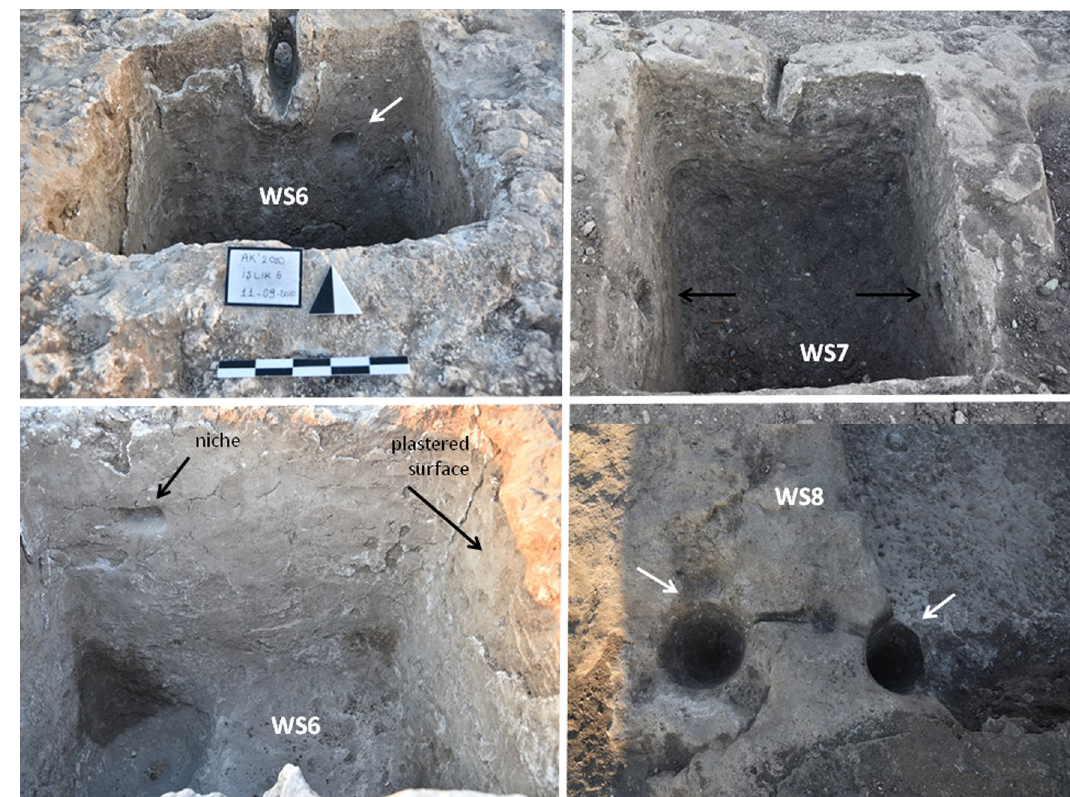
Figure 8: Sample niches in the collecting pools and traces of plaster ( right below ) ( Ambarçay Salvage Excavation Archive ) .